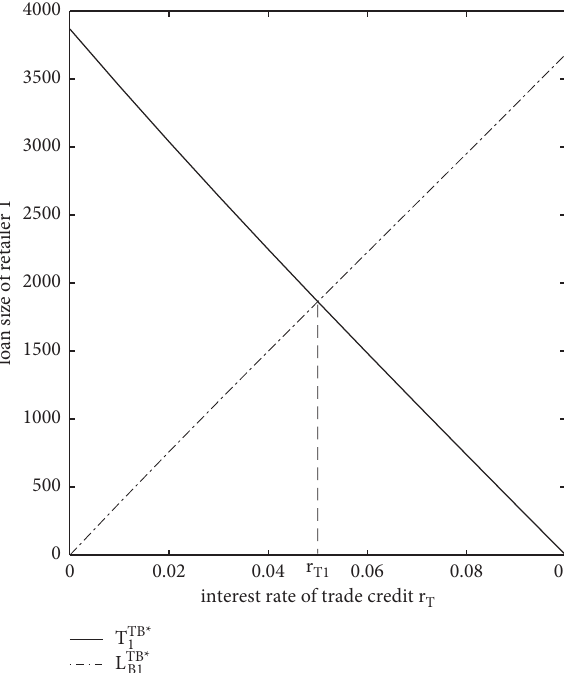
Figure 23: Loan size allocation of retailer 1.